Question: State the chart type depicted above.
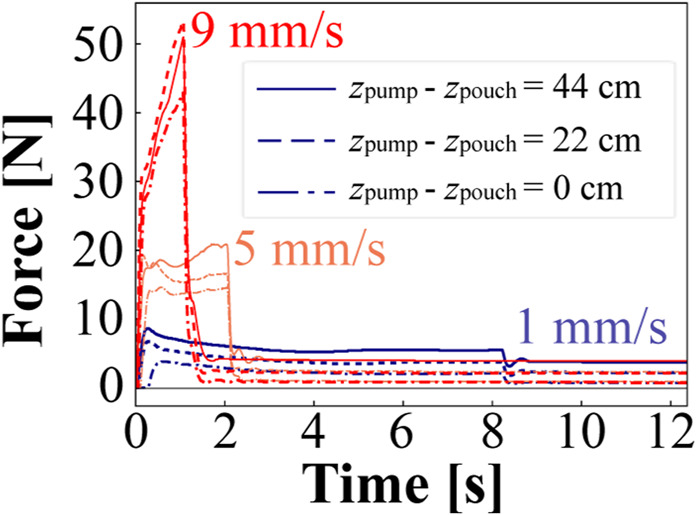
Answer: line